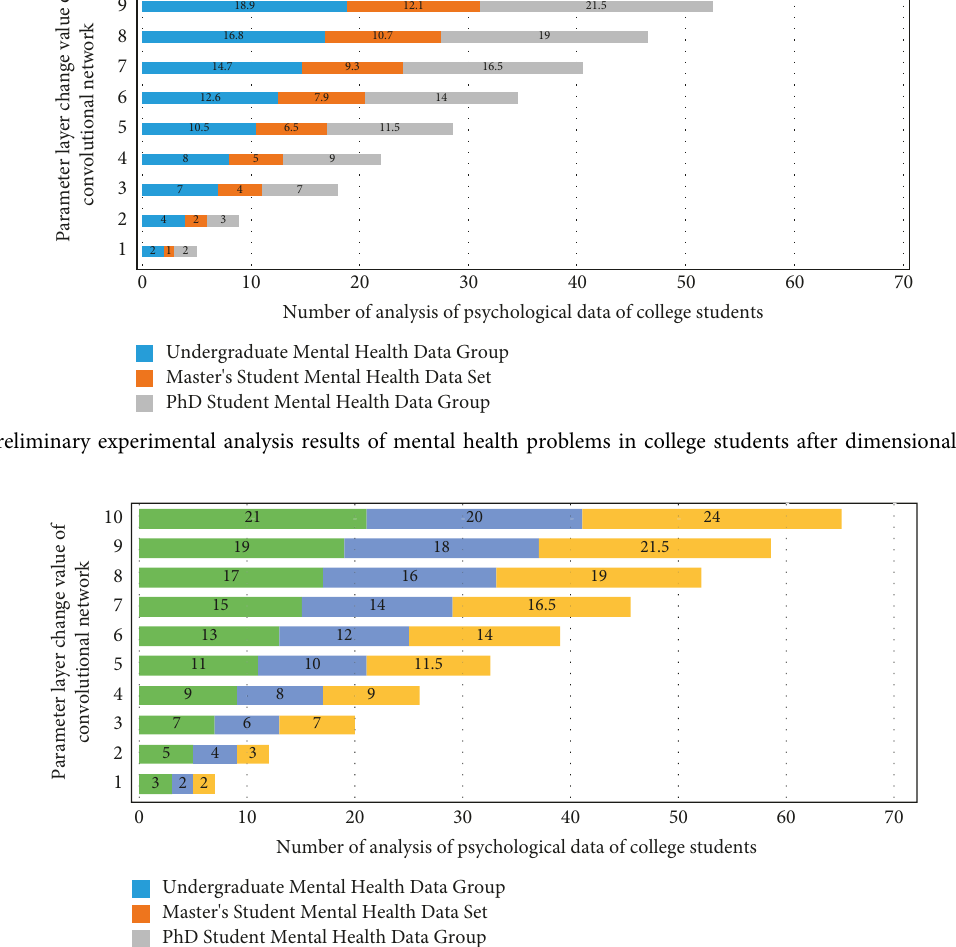
Figure 7: Final experimental analysis results of mental health problems in college students after dimensionality reduction.